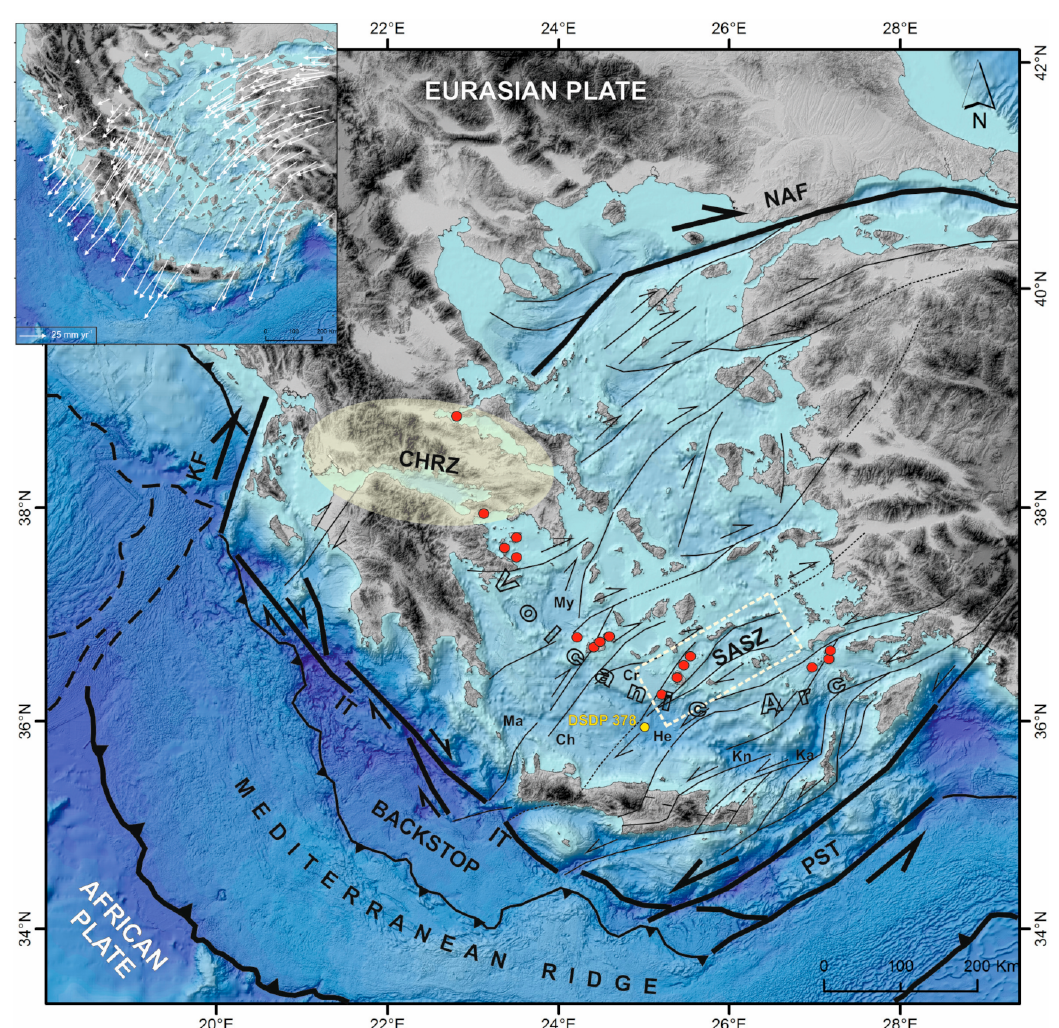
Figure 1. Major geodynamic elements of the broader Aegean Region, modified after Sakellariou and Tsampouraki-Kraounaki (Dimitriadis, I.; et al. 2009). The white parallelogram delineates the study area. Red dots represent the volcanoes on the Hellenic Volcanic Arc. NAF: North Anatolian Fault, KF: Kephallinia Fault, IT: Ionian Trench, PSF: Pliny-Strabo Trenches, CHRZ: Central Hellenic Relay Zone, SASZ: Santorini-Amorgos Shear Zone. Basins: Cr: Christiana, He: Heraklion, Ka: Karpathos, Kn: Kamilonissi, Ma: Maleas, My: